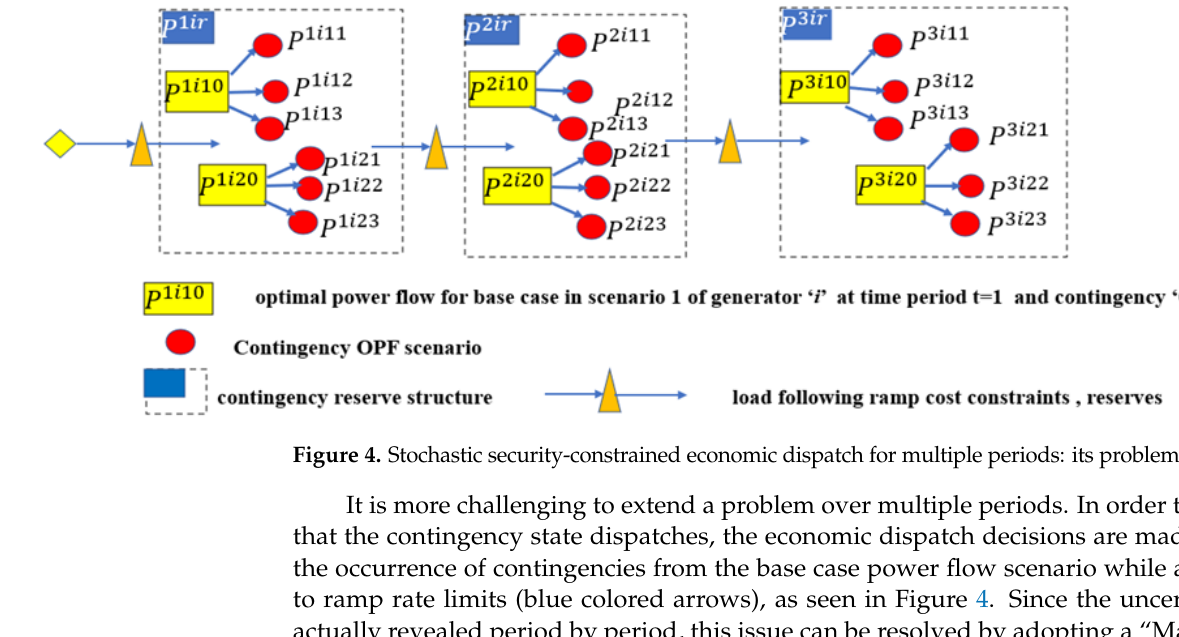
Figure 3. Problem structure for a single-period stochastic economic dispatch with multiple base case scenarios.